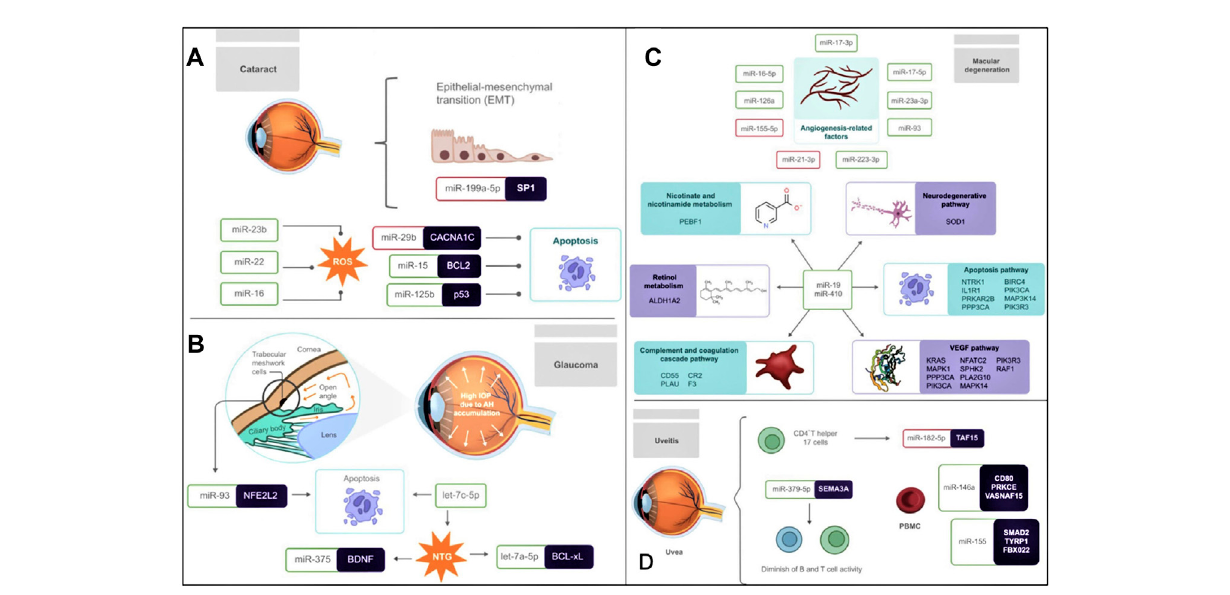
FIGURE 1 AssociationofmiRNAsinthepathogenesisof (A) cataract (B) glaucoma (C) maculardegeneration (D) uveitis (A) Thedifferentialexpressionofseveral miRNAs strongly in fl uences Cataractogenesis. miR-199a-5p is downregulated and targets SP1, therefore affecting the EMT of LECs. ROS is another contributing factor to the development of cataracts, and their formation is promoted by the upregulation of miR-23b, miR-22, and miR-16. Also, LECs apoptosis is another crucial biological mechanism in fl uenced by the downregulation of miR-29b and the upregulation of miR-15 and miR-125b, which target CACNA1C, BCL2, and p53, respectively. (B) Glaucoma is characterized by the accumulation of AH in front of the eye leading to high IOP. In addition, the upregulation of miR-93, which targets NFE2L2, triggers apoptosis in GTM cells. In NTG, let-7c-5p and let-7a-5p are related to apoptosis, while the targeting of BDNF by miR-375 has been related to neurogenesis, aging, apoptosis, and autophagy. (C) In macular degeneration, the levels of angiogenesis-related factors are correlated with the upregulation of miR-17-3p, miR-17-5p, miR-23a-3p, miR-93, miR-223-3p, miR-126a, and miR-16- 5p,aswellasthedownregulationofmiR-155-5pandmiR-21-3p.MiR-19andmiR-410aresigni fi cantlyrelevantinmaculardegenerationsincetheytarget multiplegenesinvolvedinprocesses suchasnicotinateandnicotinamidemetabolism, theneurodegenerativepathway,theapoptosispathway,theVEGF pathway, the complement, and coagulation cascade pathway and retinol metabolism. (D) The pathogenesis of uveitis is related to the differential expression of several miRNAs. Underexpressed miR-182-5p in EAU mouse-derived-Th17 cells negatively regulates its development. While the upregulation of miR-146a and miR-155 was observed in PBMC, decreasing the expression of the immunosuppressive cytokine TGF β , resulting in in fl ammation.TheupregulationofmiR-379-5p,whichtargets SEMA3A,isalso linkedtodecreased BandTcellactivity.MiRNAsinside aredboxrepresent downregulation and miRNAs inside a green box represent